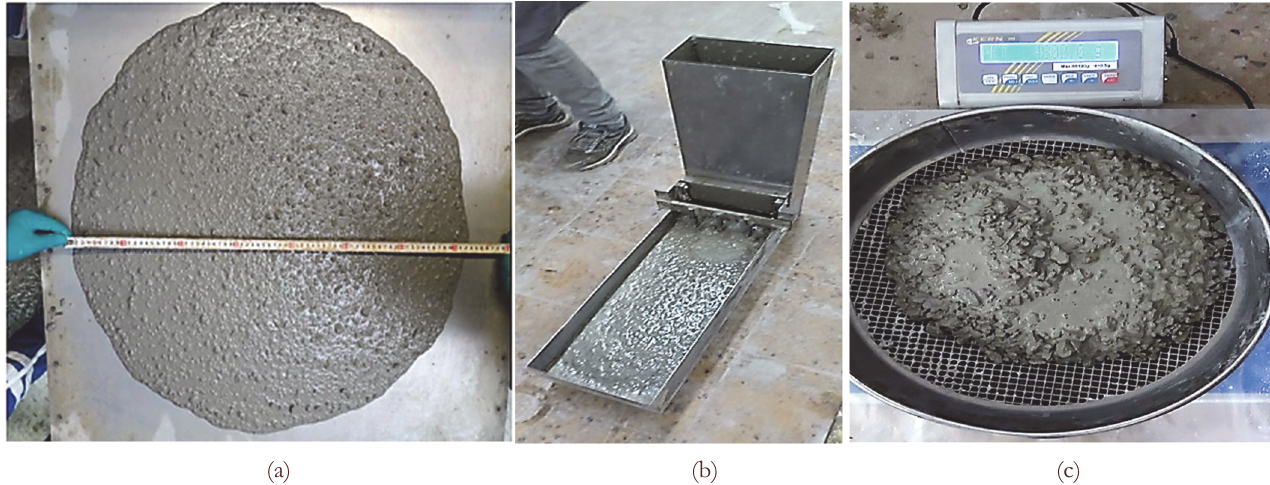
Figure 9: workability study of SCC by the tests: (a) Abrams cone spreading and T500 tests, (b) Filling power tests (the L box) and (c) Segregation stability